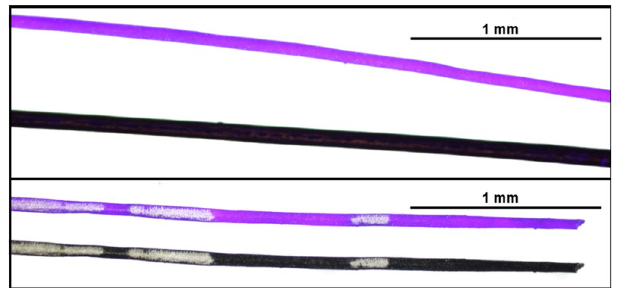
Figure 4. Biofluorescent hair of springhare. (Top panel) Biofluorescent hair of Pedetes capensis compared to the non-biofluorescent hair of a human photographed under 395 nm ultraviolet light at 4× magnification with a 100 ms exposure, and (bottom panel) a single strand of P. capensis hair photographed under 395 nm ultraviolet light and visible light at 4× magnification with a 100 ms exposure; highlighting variation observed in hair pigmentation and fluorescence.